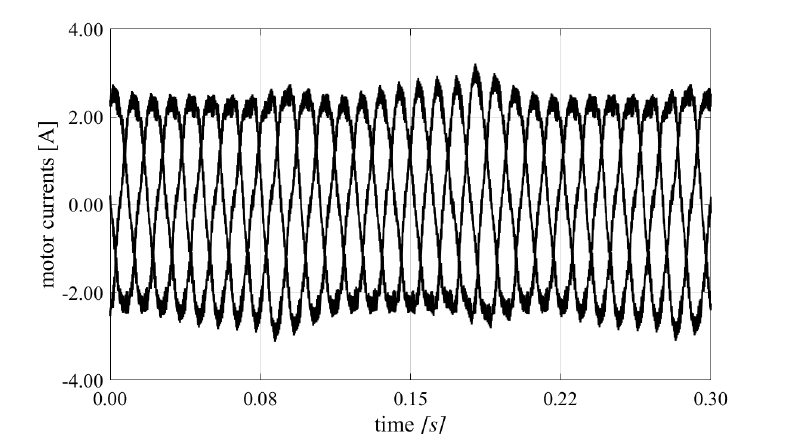
= v ∗ = 200 V, and T l = 3.5 Nm. C1 C2